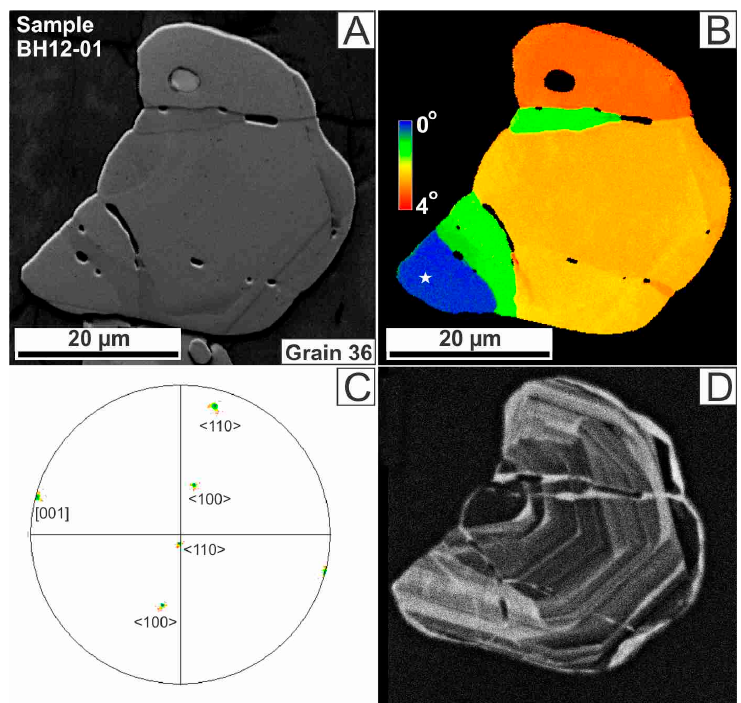
Figure 5. Data on the grain 36, sample BH12-01. ( A ) EBSD pattern quality map. ( B ) Cumulative misorientation or texture component EBSD map, showing the orientation of every data point with respect to a user-selected reference point (white star). Misorientation varies from 0 (blue) to 4° (red). ( C ) Lower hemisphere equal area projection pole figure, showing unsystematic dispersion of the crystallographic axes [001], <100> and <110>. Color-coding as in the EBSD map in B. ( D ) Panchromatic CL image.